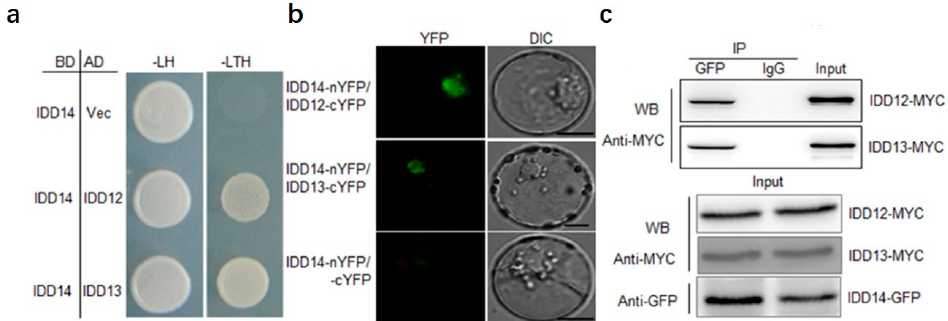
Figure 3. IDD14 interacts with IDD12 and IDD13: ( a ) yeast two-hybrid assay was used to test IDD14 interaction with IDD12 and IDD3. BD: GAL4-DNA binding domain; AD: activation